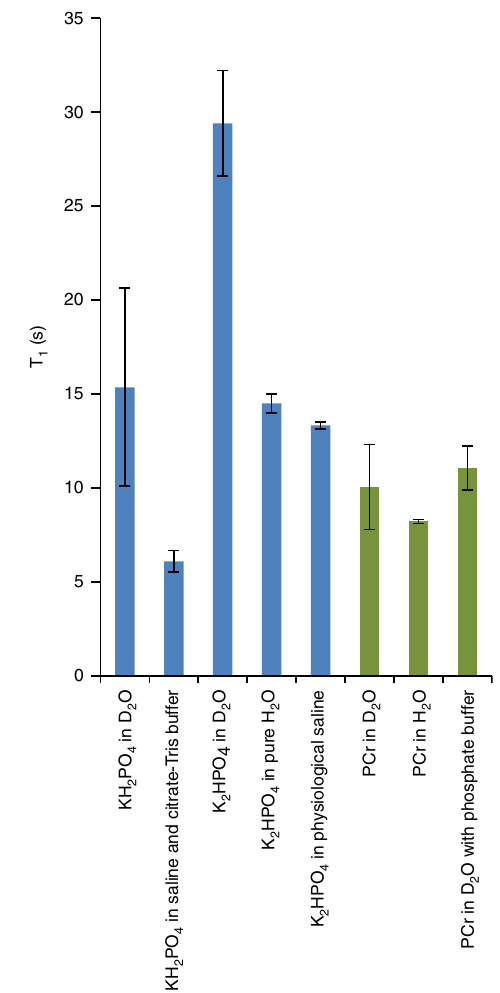
Fig. 1 Summary of T 1 relaxation time constants for hyperpolarized phosphates in aqueous media. The average value of n measurements is given and the error bars represent the standard deviation. The hyperpolarized decay curves were recorded at room temperature. The concertation of the hyperpolarized phosphate, the pH, and the number of measurements for each condition was as follows: KH 2 PO 4 in D 2 O: 0.94 ± 0.14 mM, pH 5.1, n = 2; KH 2 PO 4 in saline and citrate-Tris buffer: 0.43 ± 0.07 mM, pH 4.5, n = 2, includes two experiments with N 2 bubbling and two experiments without N 2 bubbling. K 2 HPO 4 in D 2 O: 1.80 ± 0.90 mM, pH 8.1, n = 5 K 2 HPO 4 in pure H 2 O: 2.95 ± 0.03 mM ( n = 3), 34.93 mM ( n = 1), pH 8.1 (altogether four experiments; one experiment was performed with a 2 M concentrated formulation of Pi, resulting in a high concentration in the NMR tube). K 2 HPO 4 in physiological saline: 1.14 ± 0.02 mM, pH 8.1, n = 2 PCr in D ± 0.71 mM, pH 6.5, n = 2; PCr in H ± 2 O: 2.17 2 O: 2.78